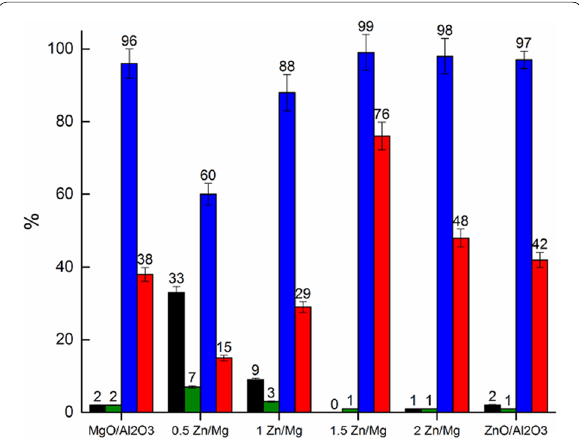
Fig. 6 Selectivity to monoglycerides (black square), diglycerides (green square) and FAME (blue square), and FAME yield (red square) obtained for each catalyst, in the transesterification of soybean oil with methanol